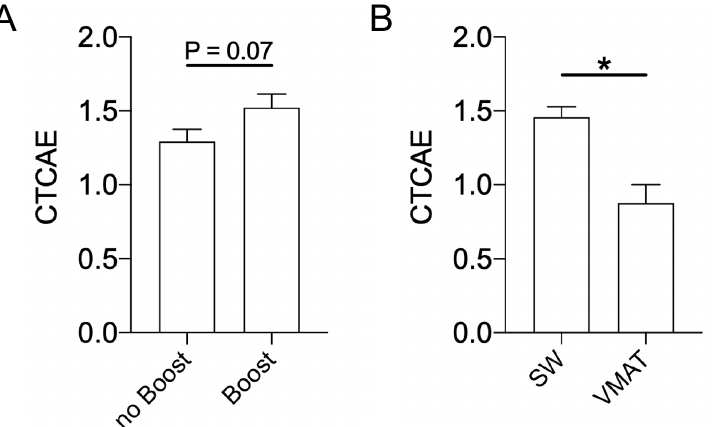
Figure 4. Impact of a sequential boost RT and treatment technique on RID severity. ( A ) Comparison between boost and no boost for RID severity. ( B ) Dermatitis severity is evaluated by different radiation techniques. Sliding window IMRT (SW) and volumetric-modulated arc therapy (VMAT) were compared by unpaired t -tests with * for p < 0.05.